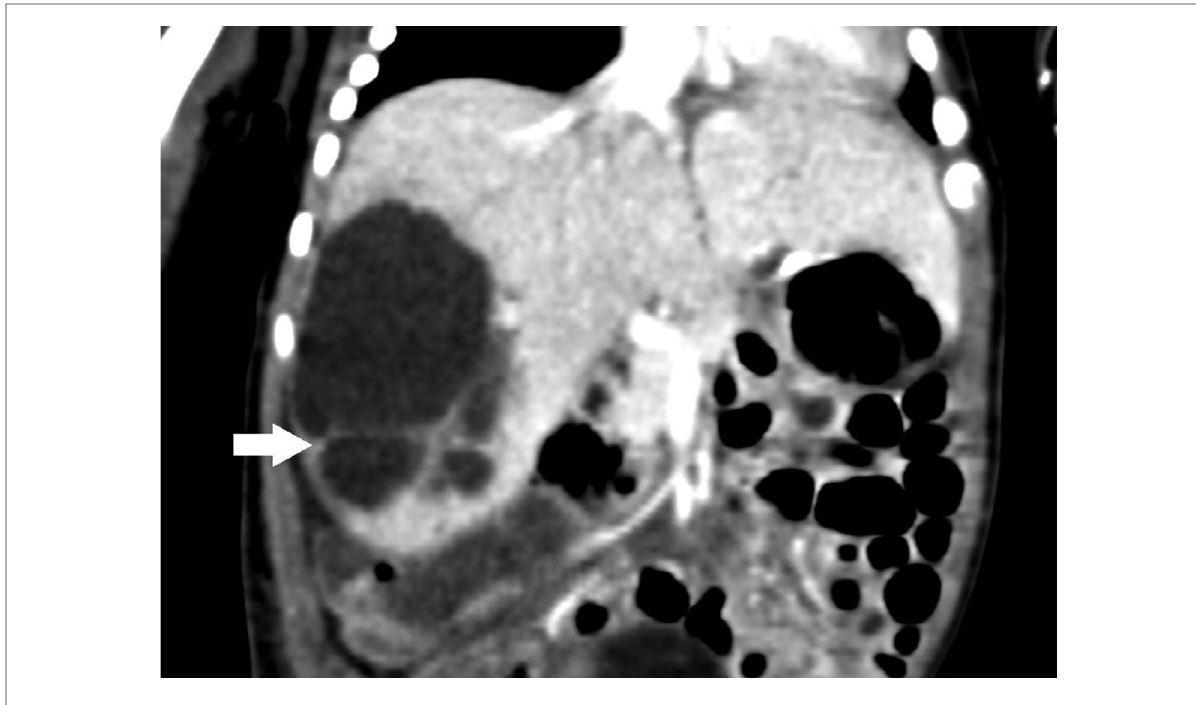
FIGURE 2 Computed tomography (CT) scans of the abdomen. CT scans showed a circular cystic mass in the right lobe of the liver, with multiple linear partitions and clear boundaries. On contrast enhanced CT scans, the capsule and septum enhanced, but no enhancement was found inside the tumor (arrow).